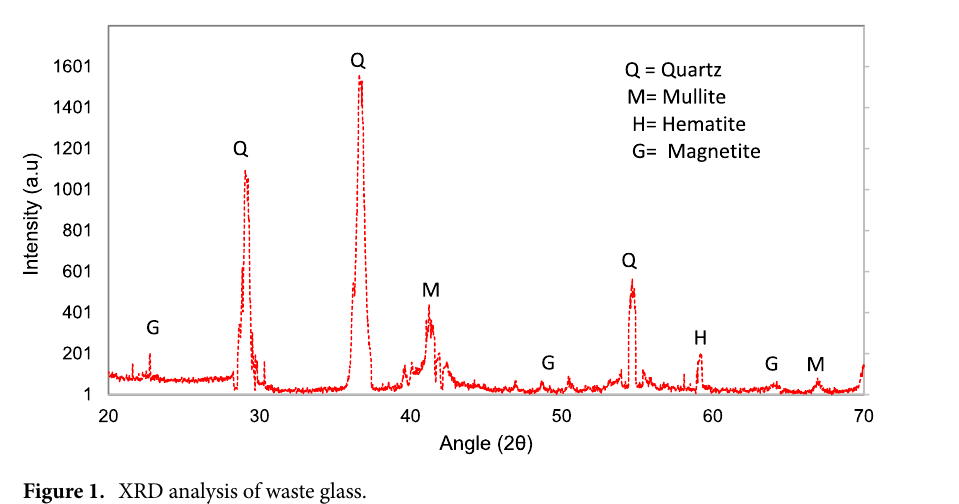
Figure 1. XRD analysis of waste